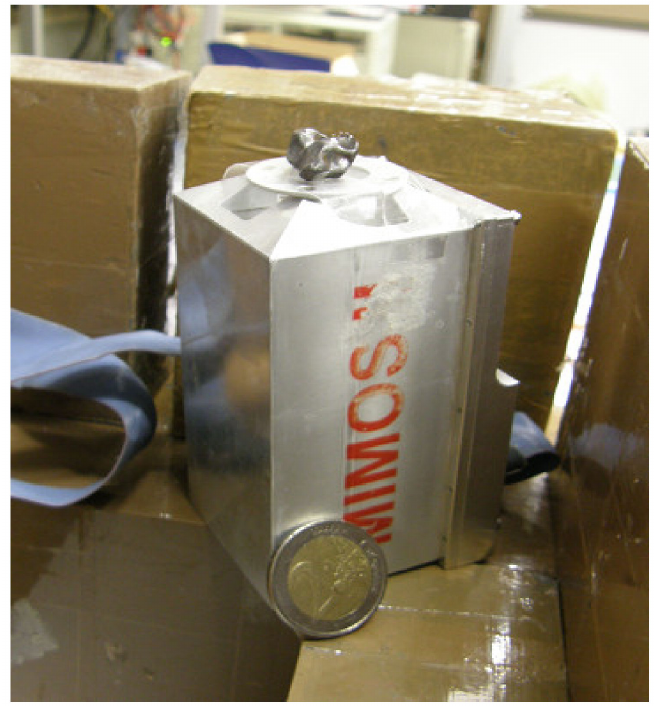
Figure 6. MIMOS II spectrometer measuring an iron meteorite placed on top of the